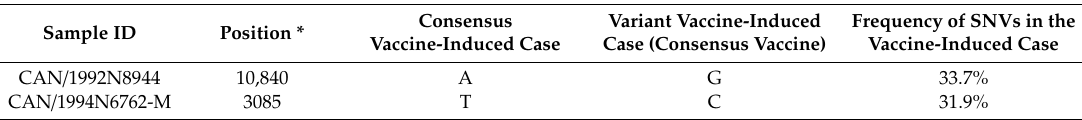
Table 5. Viruses of ERA vaccine-induced rabies cases that maintained the vaccine consensus in the form of an